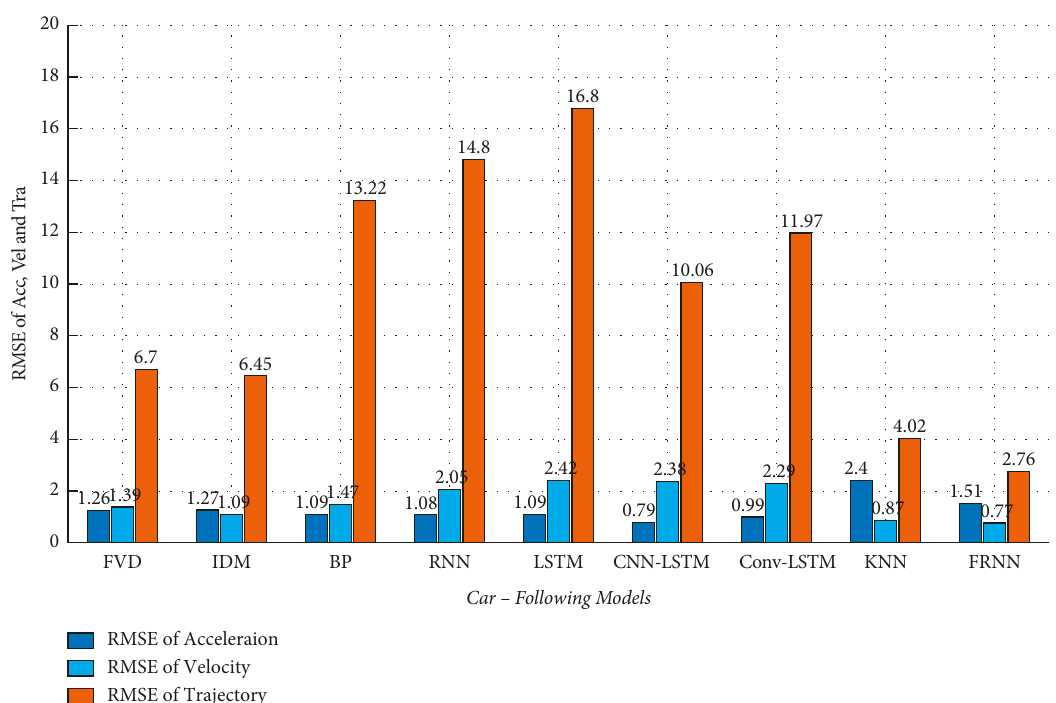
Figure 19: RMSE of conventional models and data-driven models in the discontinuous traffic flow (ANN CF-A).